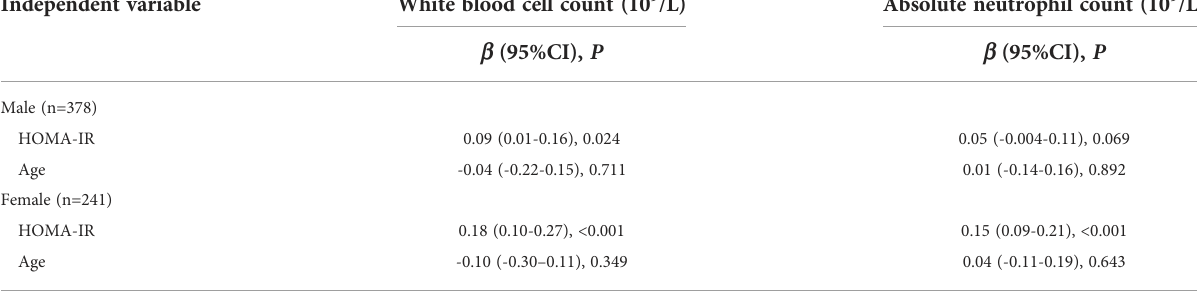
TABLE 5 Sex differences in multiple linear regression analysis of HOMA-IR and white blood cell count/absolute neutrophil count adjusted for age in children with overweight and obesity. Independent variable